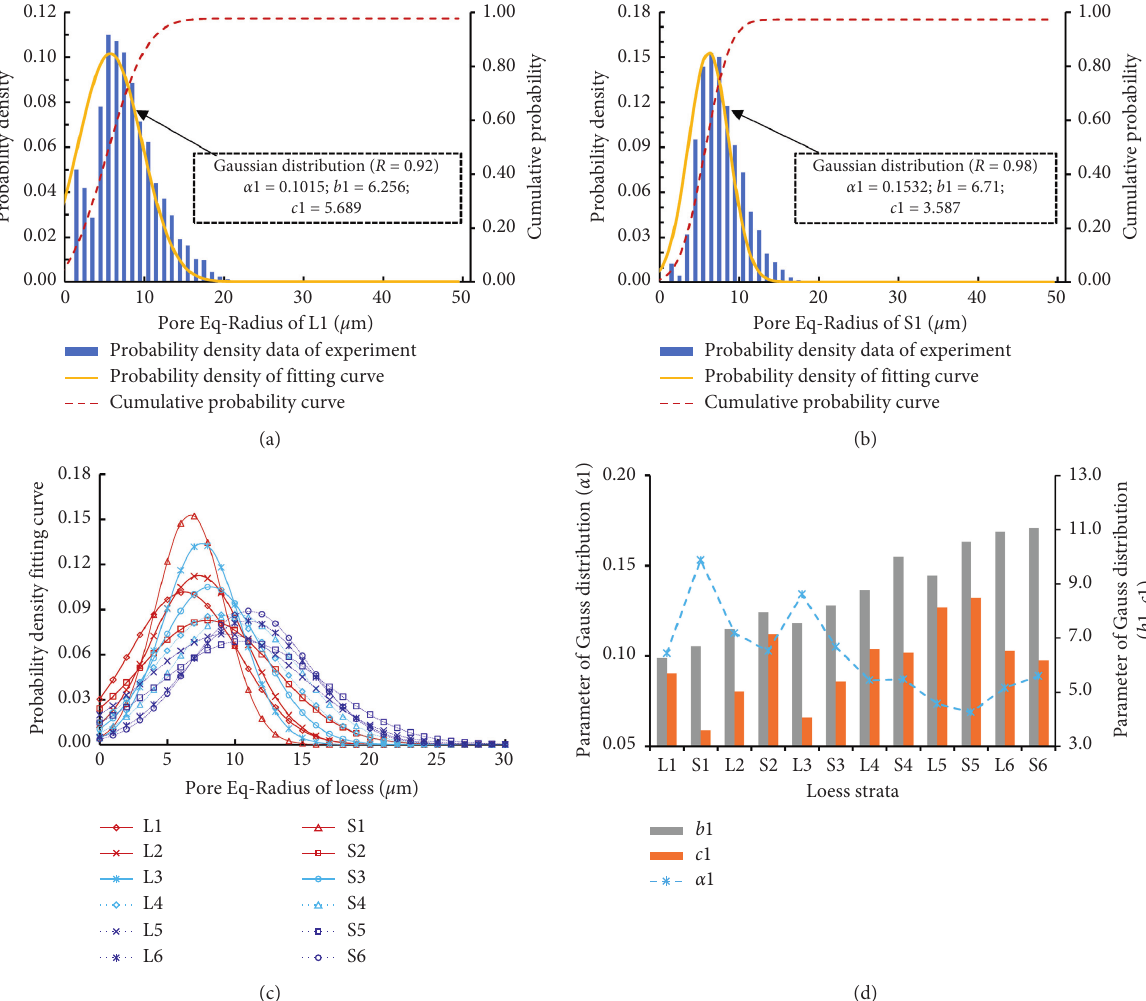
Figure 11: Distribution characteristics of pore Eq-Radius for loess: (a) probability density versus pore Eq-Radius of L1; (b) probability density versus pore Eq-Radius of S1; (c) distribution characteristics of pore Eq-Radius for various layers; (d) variation in fitting parameters for various layers of